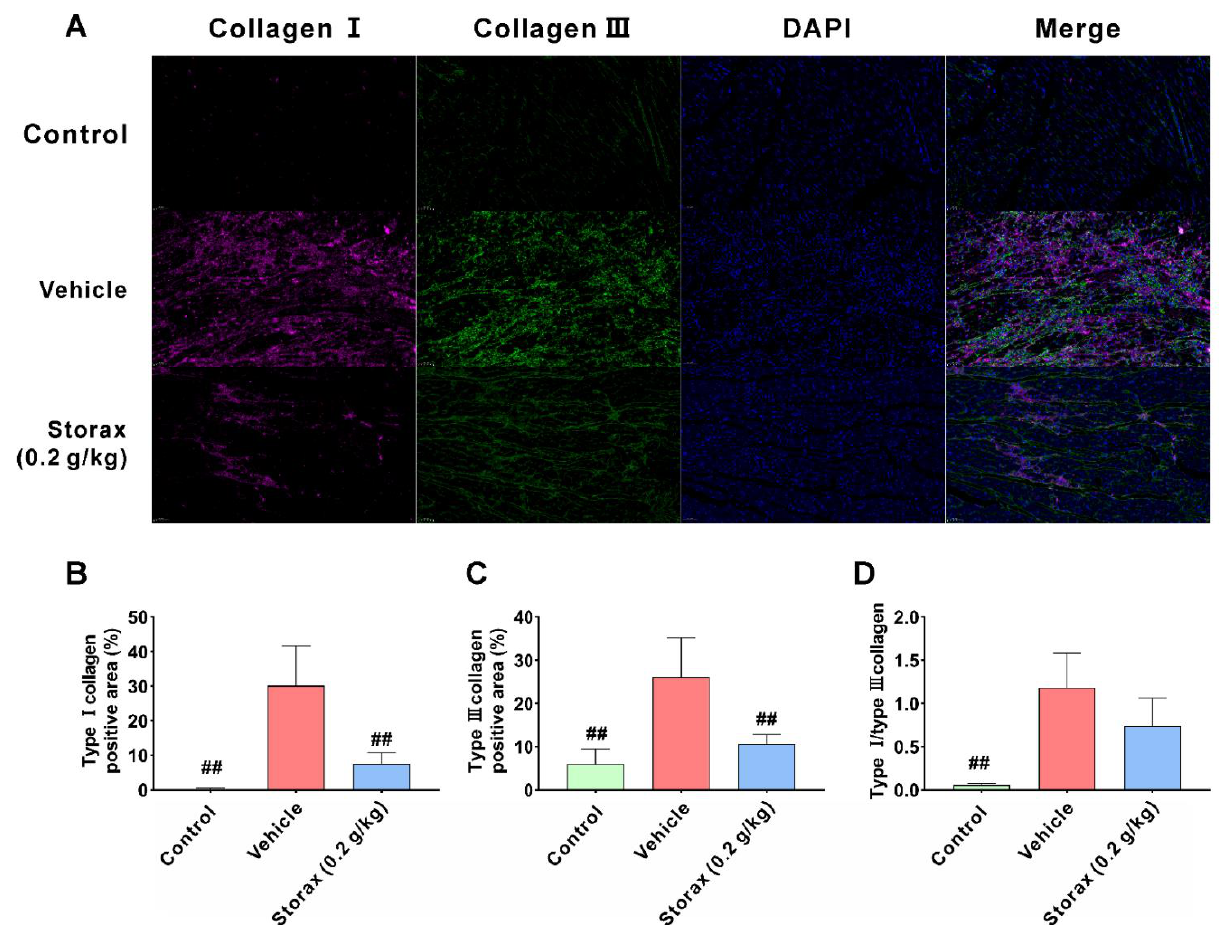
Figure 6. The effect of storax on the expression of type I and III collagen in the myocardium of ISO-induced AMI rats. ( A ) Representative images of myocardial type I and III collagen immunofluorescence staining in each group of rats. Type I collagen immunofluorescence staining was shown in pink, type III collagen immunofluorescence staining was shown in green and DAPI nuclear staining was shown in blue (scale bar = 50 μm). ( B ) Quantitative analysis of collagen type I. ( C ) Quantitative analysis of collagen type III. ( D ) Quantitative analysis of the ratio of collagen I/III. Results are presented as mean ± SD (n = 4). One-way ANOVA followed by Bonferroni’s post hoc test: ## p < 0.01 vs. vehicle group.